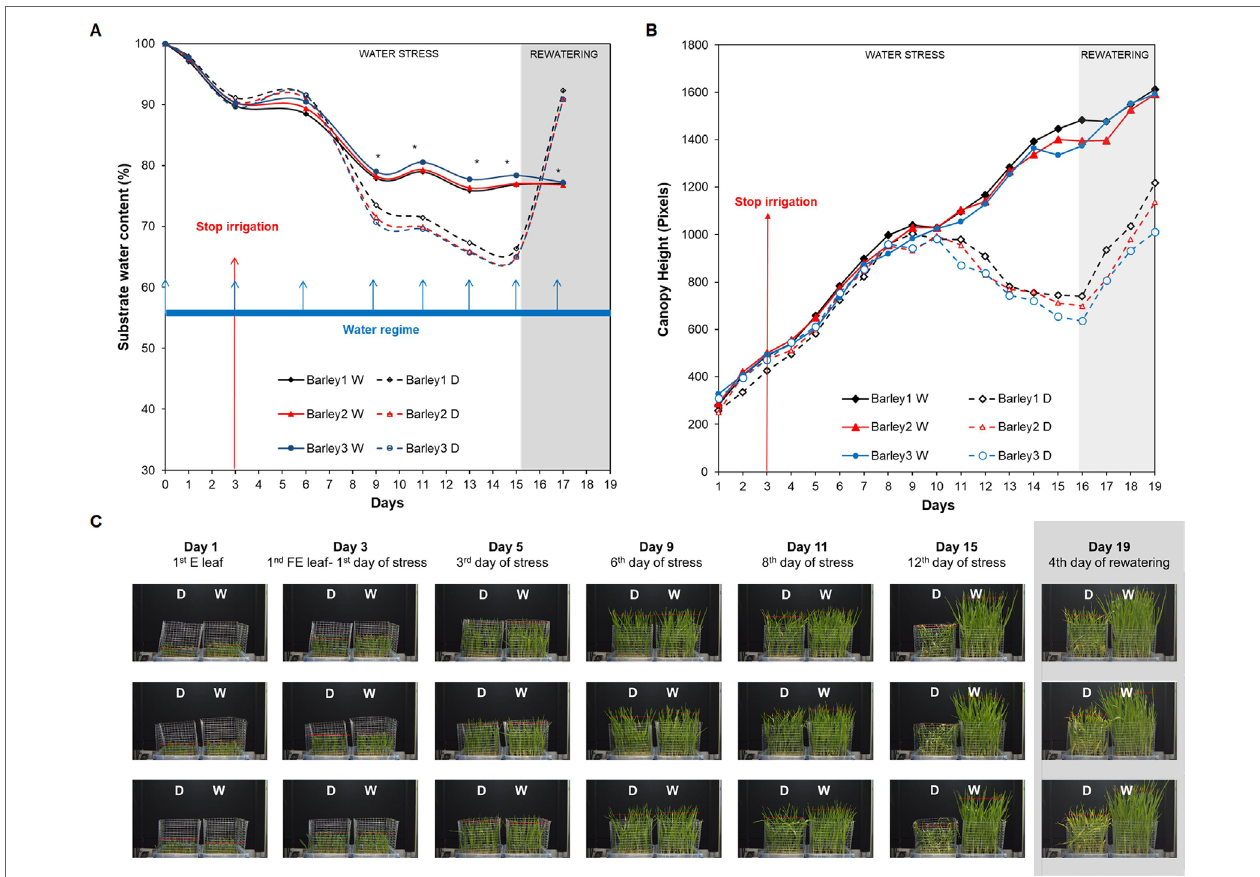
FIGURE 3 | Dynamics of soil moisture and projected canopy height in barley seedlings growing under water stress conditions with subsequent rewatering. (A) Changes in substrate water content (%) of non-stressed (W, continuous lines) and stressed (D, discontinuous lines) barley seedlings (n = 50) from three independent trays (Barley 1, 2, and 3) grown for 13 days under water deficit conditions (with the endpoint at day 16) and subsequently rewatered for 4 days (with the endpoint at day 19). The watering regime consisted in an initial 100% field capacity (FC) after sowing and subsequent constant 80% FC for W variants, and irrigation interruption from day 3 to day 16 for the D variants and posterior rewatering for 4 days. Blue arrows represent the watering regime and red arrow the stop of the irrigation moment in the D variant. (B) Changes in projected canopy height (in pixels) and (C) side view images of the D and W variants from the three independent replicates along the experiment. Asterisks indicate the significance level relative to the control variant after Kruskal-Wallis test. * P ≤